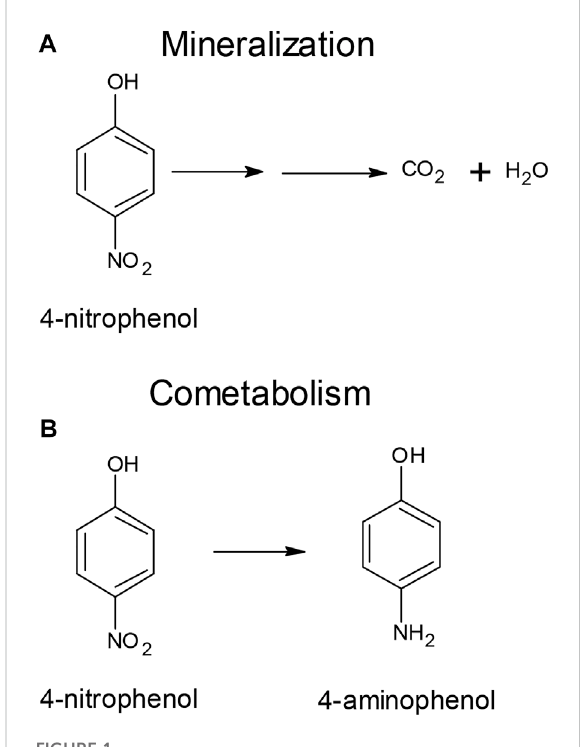
FIGURE 1 Bacterial mineralization (A) and cometabolism (B) of 4-